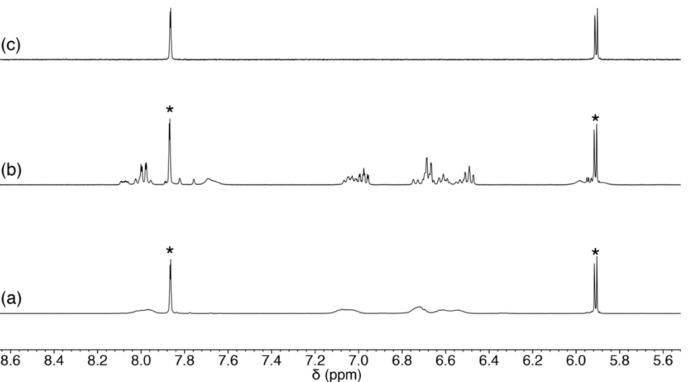
Figure 8. 1 H NMR spectra of ( a ) the reaction mixture of 1 and 5-methyluridine, ( b ) 1 , 5-methyluridine, and triethylamine, and ( c ) 5-methyluridine in CD 3 OD. The resonances for unreacted 5-methyluridine are marked with